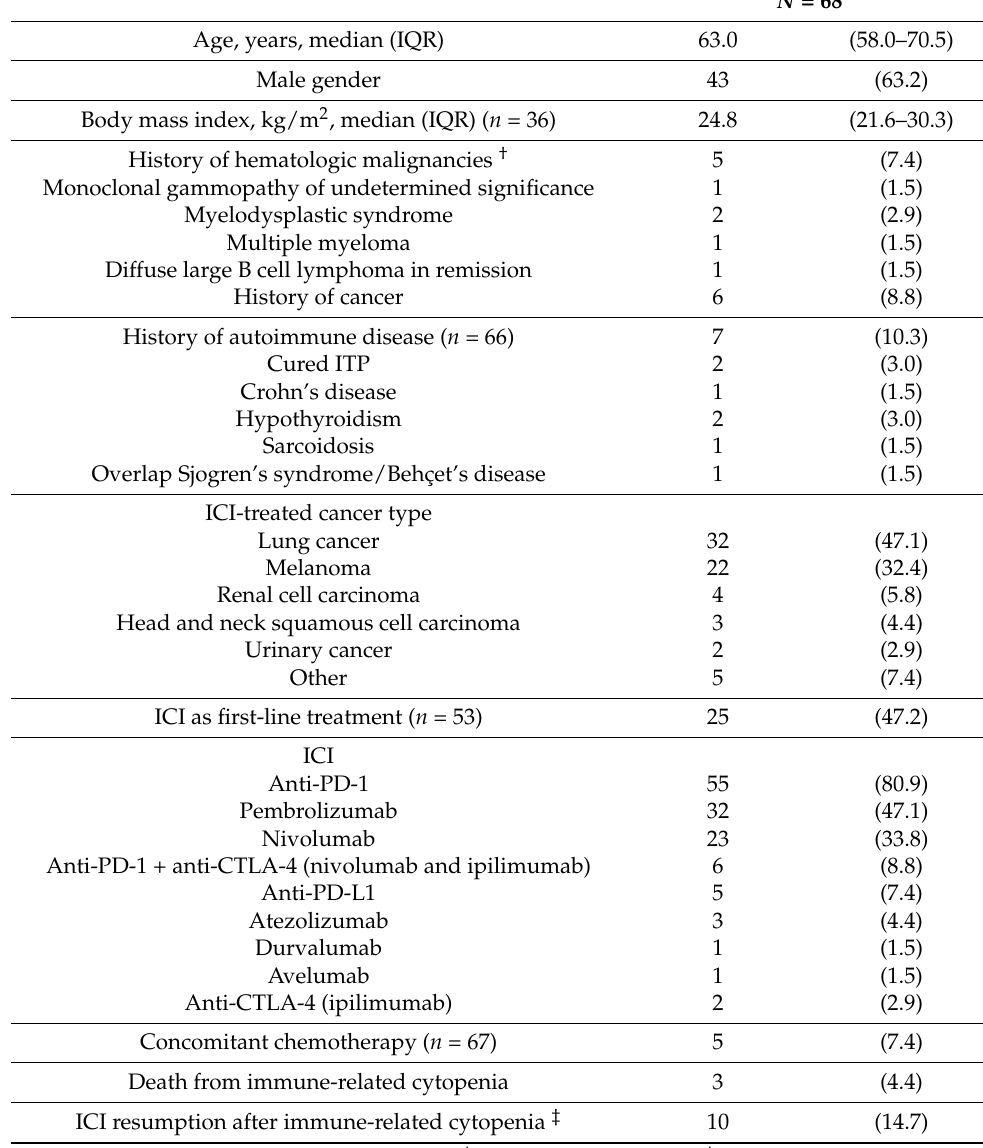
Table 1. Characteristics of the study